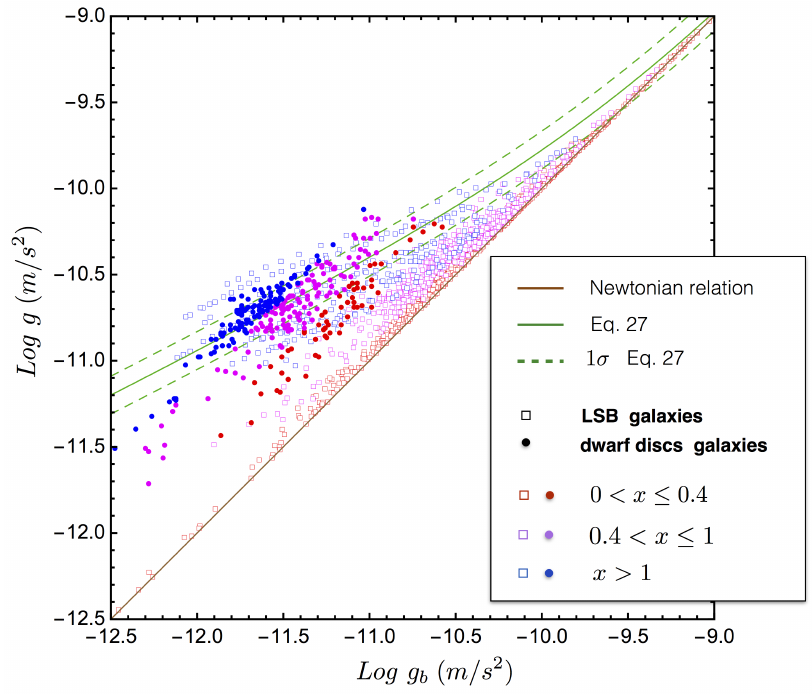
Figure 25. Total acceleration g vs. its baryonic component g b . x ≡ R / R opt . Additionally shown: Equation (27) (green line) and its 1 σ error bar (dashed green lines) and the Newtonian relationship: Log g = Log g b (brown line). Image reproduced from [236].